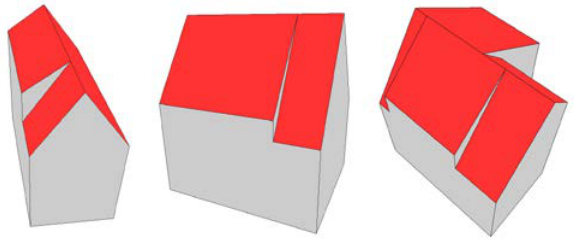
Figure 12. Reconstructed buildings consisting of adjacent gable roofs and wall